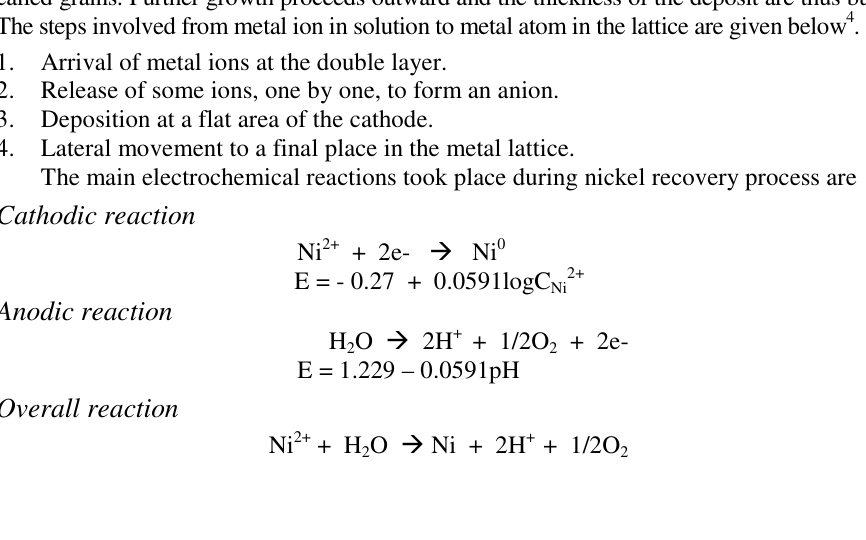
Figure 2. SEM image of gold coated mild